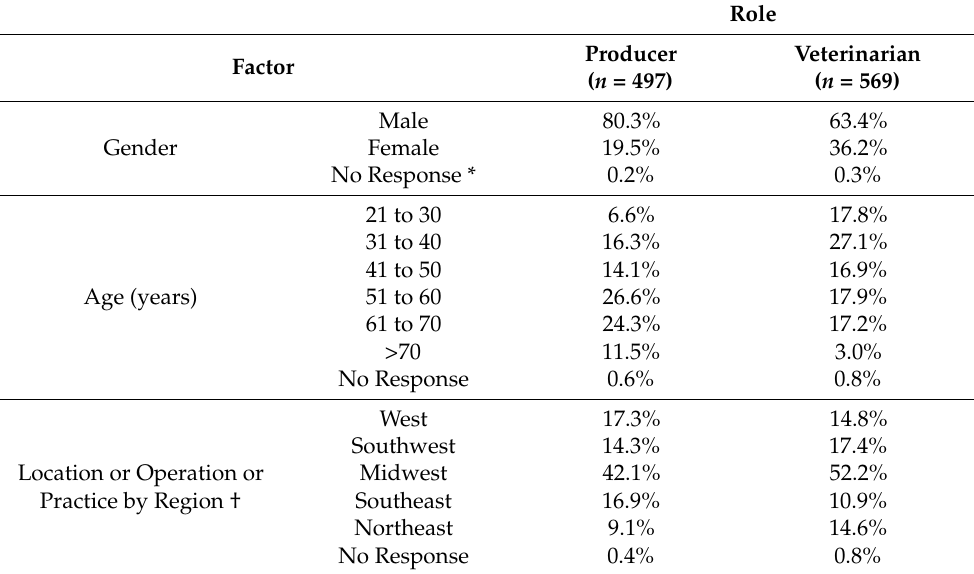
Table 1. Demographics summary of all responders ( n = 1066).